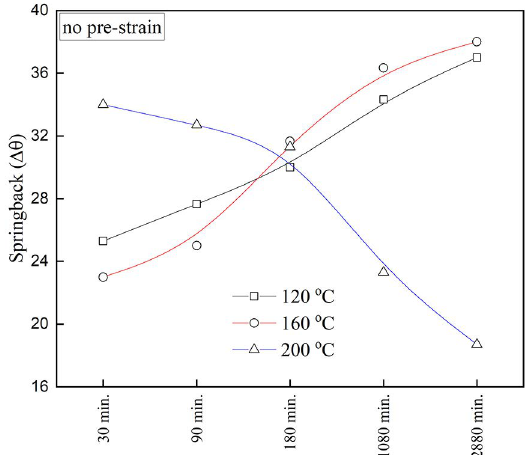
Figure 18. Effects of different aging temperatures and time on springback (no pre-strain)